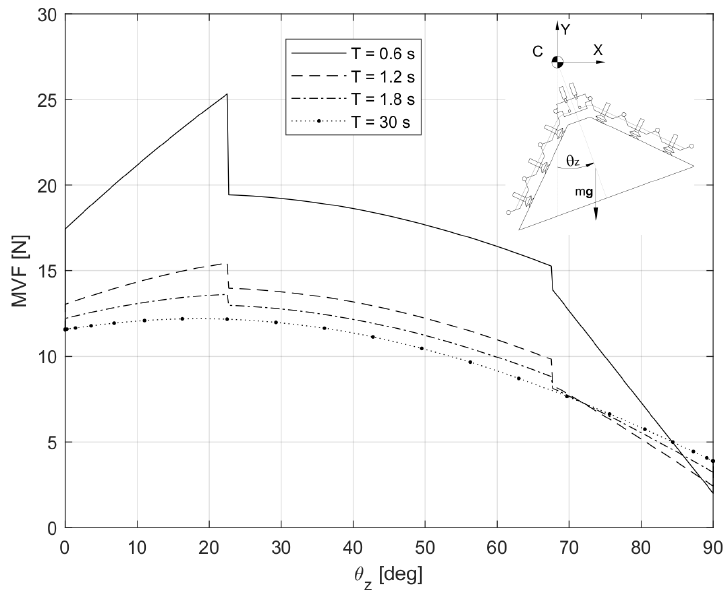
Figure 7. Minimum vacuum force required during the rotation of a trapezoid object as a function of the angle θ z that is shown in the inset. Different curves refer to increasing time T , i.e., the total time used for the rotation, as defined in Equations